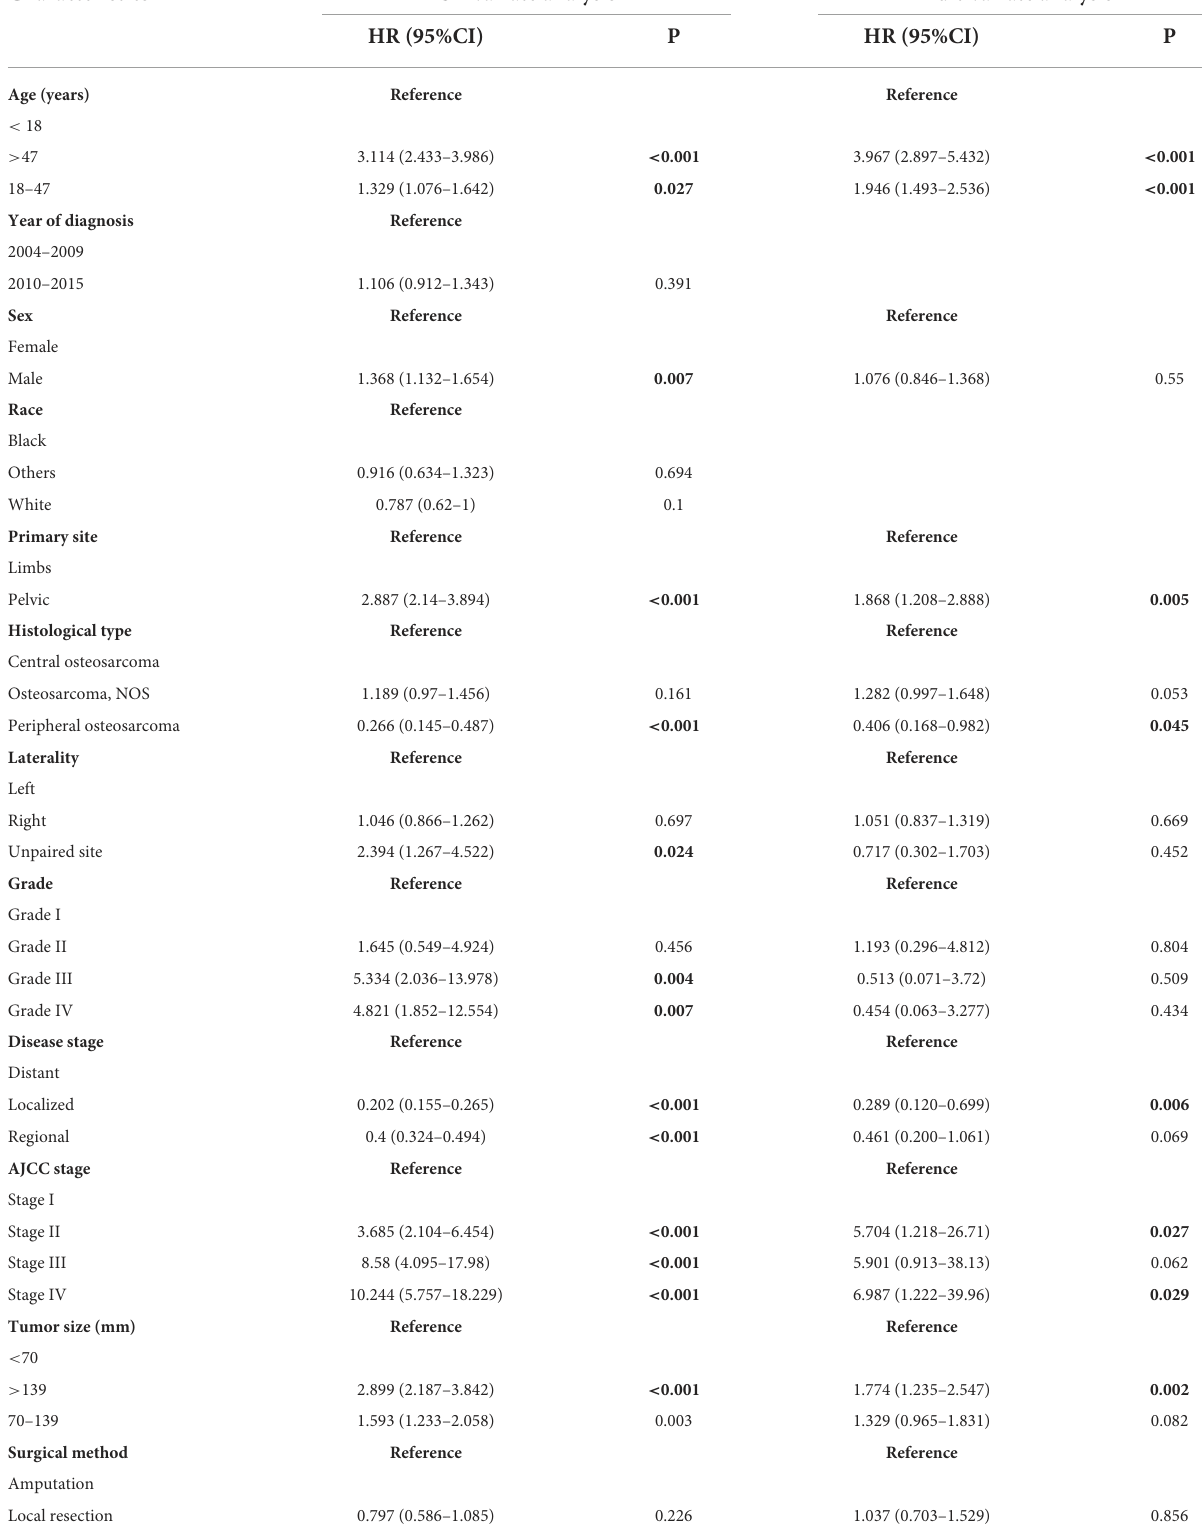
TABLE 2 Univariate and multivariate analyses of overall survival (OS) in the training cohort. Characteristics Univariate analysis Multivariate